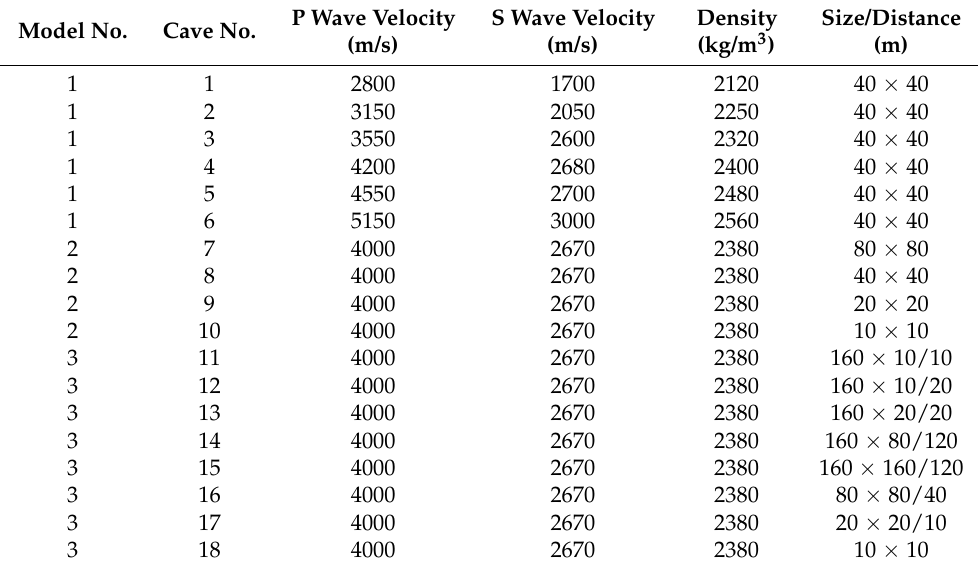
Table 1. Parameters of modeled caves. Model No. Cave No.